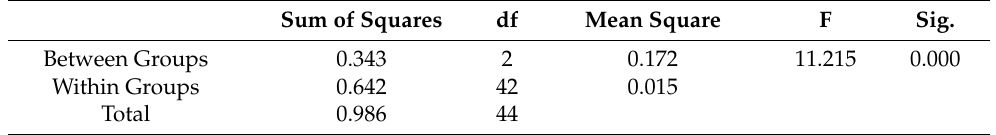
Table 2. Results of One-Way ANOVA of B-C ratio for different power sources. Sum of Squares df Mean Square